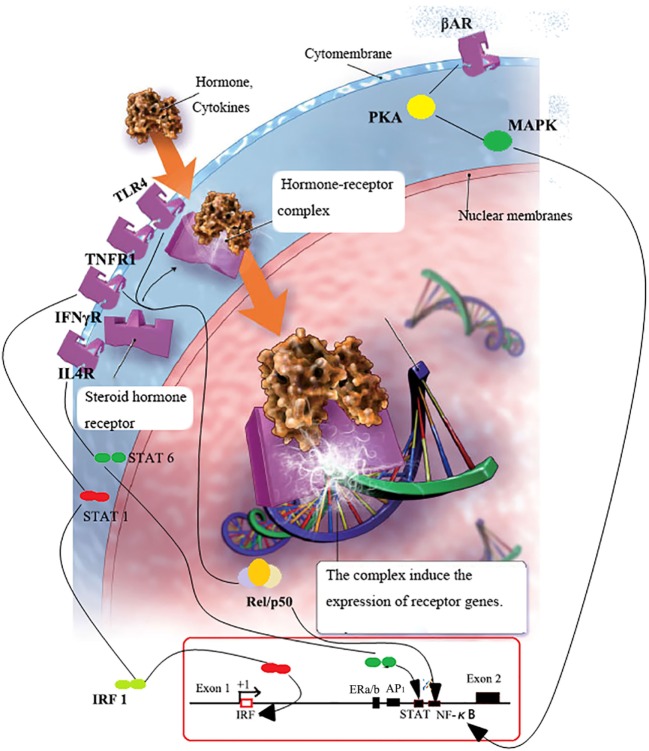
FcRn or pIgR transcription regulation. Serum NE binds with β2AR on B cells and activates PKA–p38 MAPK pathways, which subsequently leads to the release of bound p-p38 MAPK to bind with enhancer in the promoter region of pIgR, and pIgR increase followed (62). When inflammation occurs, lymphocyte homing induced antibodies production in lamina propria; subsequently, microbes bind with epithelial TLRs with MAMPs and activate NFκB; cytokines released in the vicinity of lymphocytes bind to cytokine receptors and activate IRF-1/NFκB-dependent pathways (58); IRF-1/NFκB proteins get into nucleus and trigger the transcription of Igs receptors (63). As a consequence, concentrations of Ig transporting receptors increase.